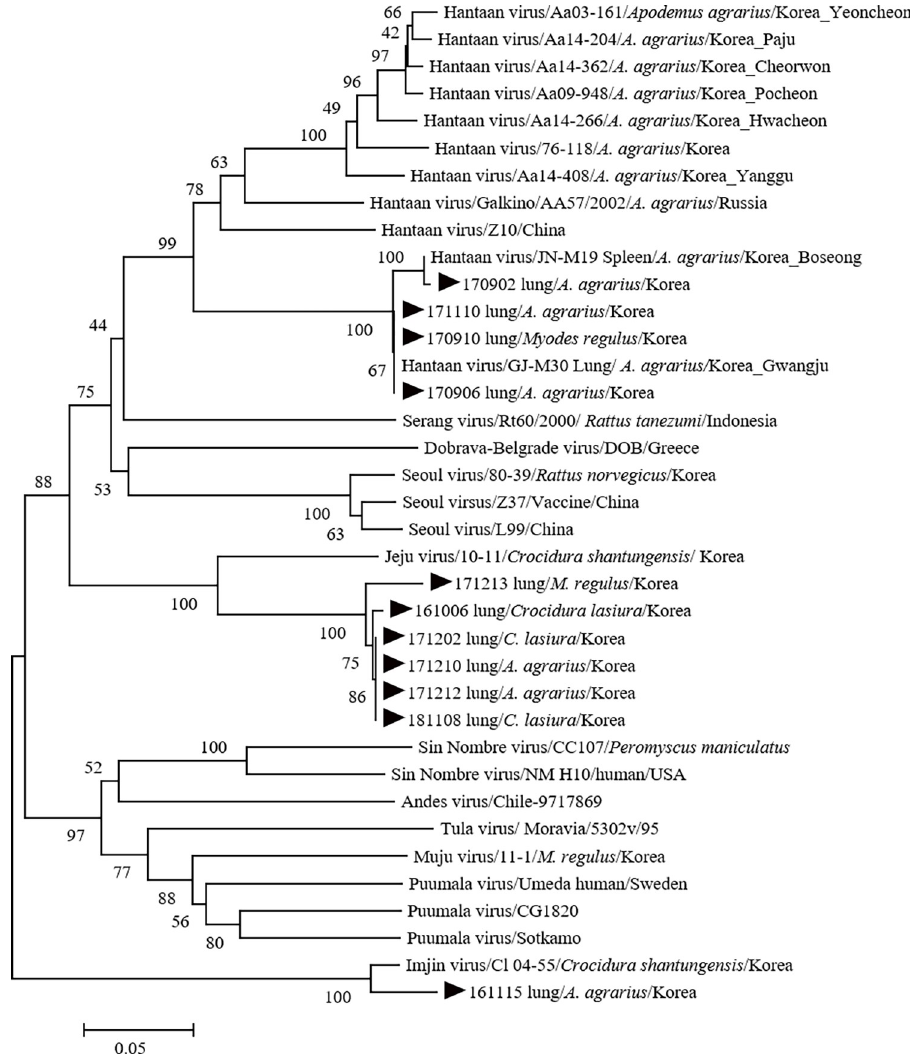
Fig 1. Phylogenetic tree based on the partial L segment sequences (356 bp) from GenBank and Hantavirus- positive wild rodent specimens captured in the Gwangju metropolitan suburban areas from January 2016 to 2018.